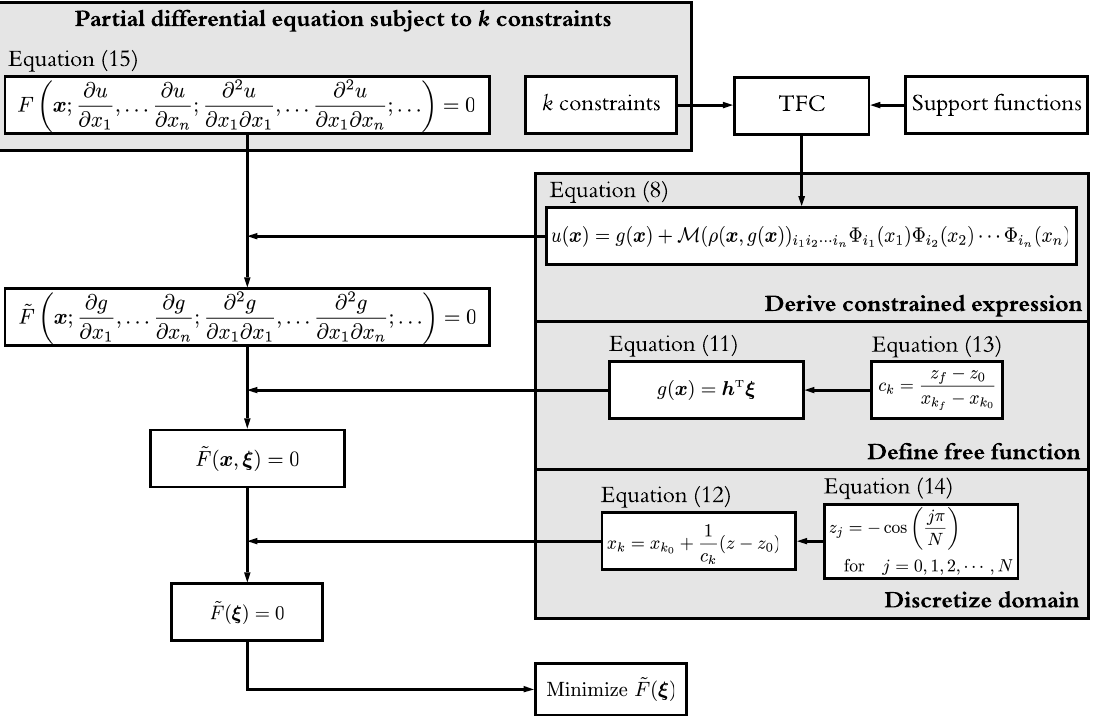
Figure 4. General flowchart of the TFC approach to solving partial differential